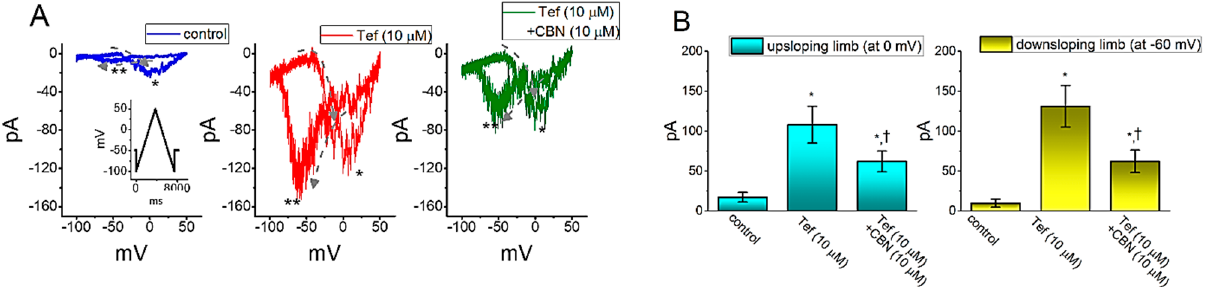
Figure 5. Inhibitory effect of CBN on tefluthrin (Tef) mediated increase in persistent I Na current ( I Na(P) ) in GH 3 cells. In these whole-cell current recordings, the cell was voltage-clamped at − 50 mV and the isosceles-triangular ramp voltage with a duration of 7.4 s (i.e., ramp speed = ± 0.04 mV/ms) was applied to activate I Na(P) in response to the upsloping (from − 100 to +50 mV) and downsloping (from +50 to − 100 mV) ramp voltage-clamp command. ( A ) Representative current trace obtained in the control (left) and during the exposure to 10 µ M tefluthrin (Tef) (middle) or to 10 µ M Tef plus 10 µ M CBN. Inset in the left panel is the voltage-clamp protocol applied for all panels in ( A ), and dashed arrows in each panel show the direction of I Na(P) in which time passes during the elicitation by the voltage-clamp command of upright isosceles-triangular ramp with a duration of 7.4 s. * and ** indicate the amplitude of I Na(P) activated by the upsloping (or forward) limb and downsloping (or backward) limb of the long-lasting triangular ramp pulse, respectively. ( B ) Summary bar graph showing the effects of tefluthrin (Tef, 10 µM) and Tef (10 µM) plus CBN (10 µM) on I Na(P) amplitude activated by the upsloping and downsloping limb of 7.4 s triangular ramp pulse. Current amplitude shown in the left side was taken at the level of 0 mV in the situations where the upsloping limb of triangular pulse was applied to evoke I Na(P) , while that in the right side was at the level of − 60 mV during the downsloping end of the pulse. * indicates significantly different from control ( p < 0.01), and † indicates significantly different Tef (10 µM) alone group ( p < 0.05).